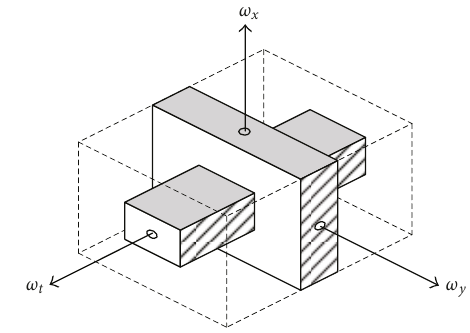
Figure 5: Spectral support shape of video clips.